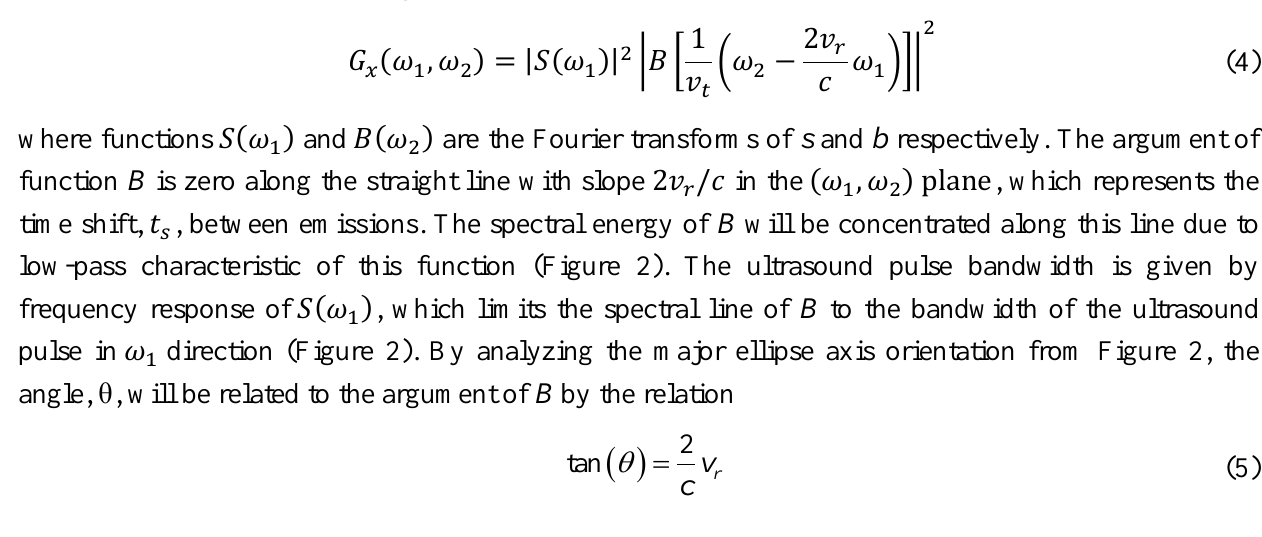
Figure 2. Data mapping in two-dimensional Fourier space showing ideal response for a pulsed Doppler ultrasound signal (complex